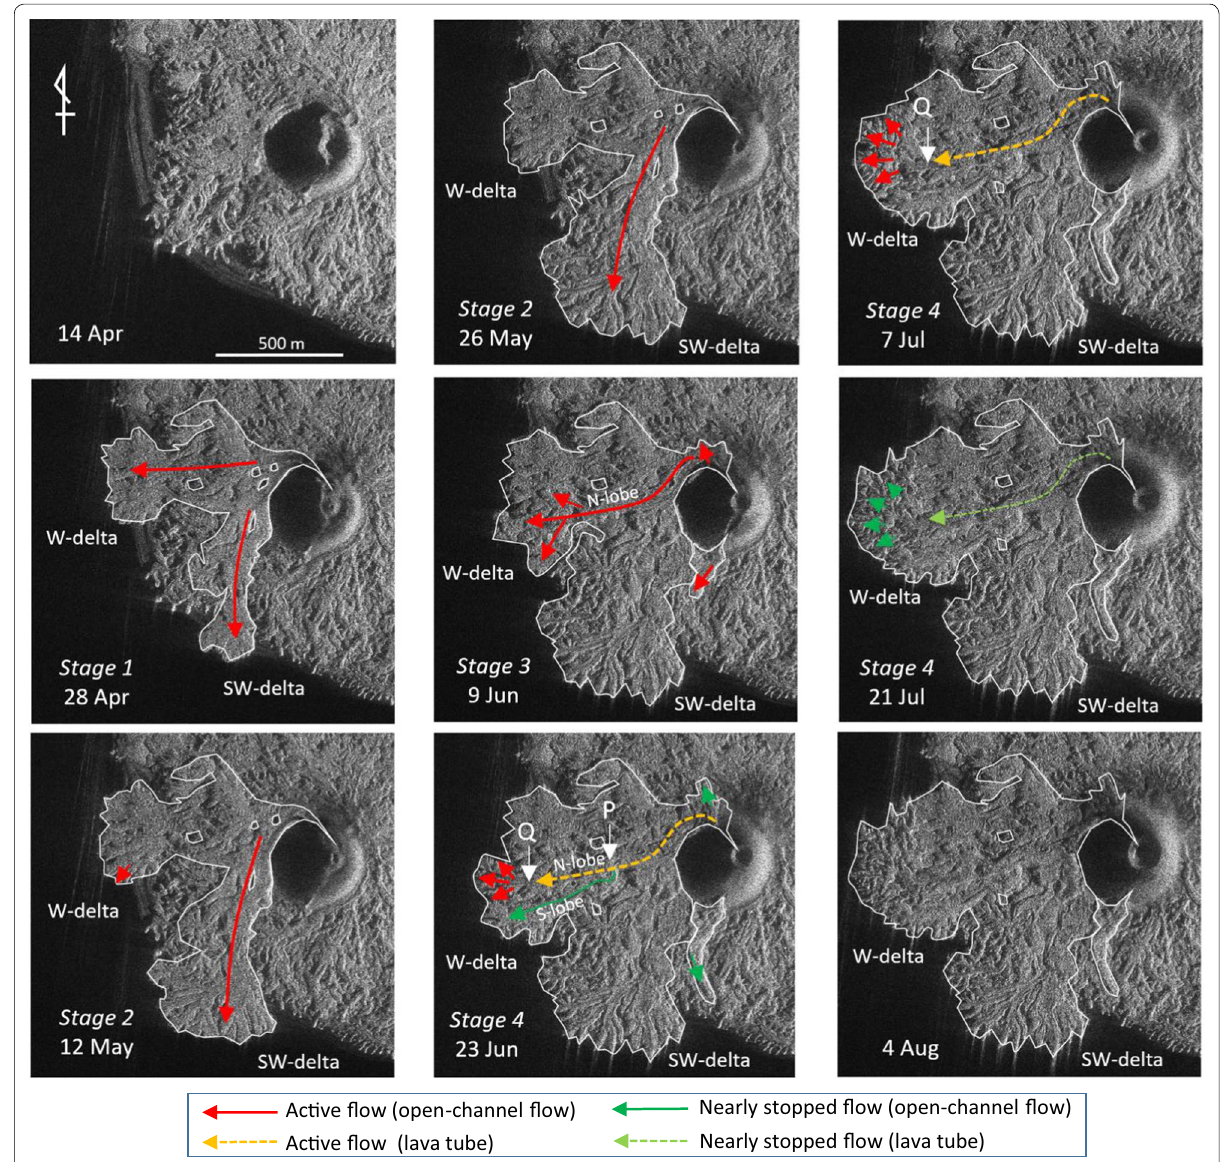
Fig. 5 ALOS-2 PALSAR-2 images of the southwestern part of Nishinoshima between 14 April and 4 August 2017. “P” marks an inflection point where the flow branched and changed direction, and “Q” indicates an effusion point of lava from the lava